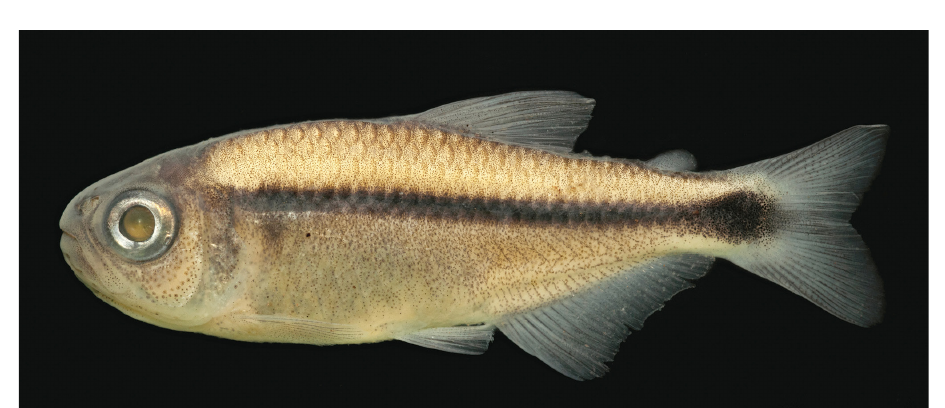
FIGURE 1 | Holotype of Astyanax nobre , MZUSP 125905, 25.6 mm SL, Brazil, Mato Grosso State, Municipality of Nobres, rio Paraguai basin, upper rio Salobra